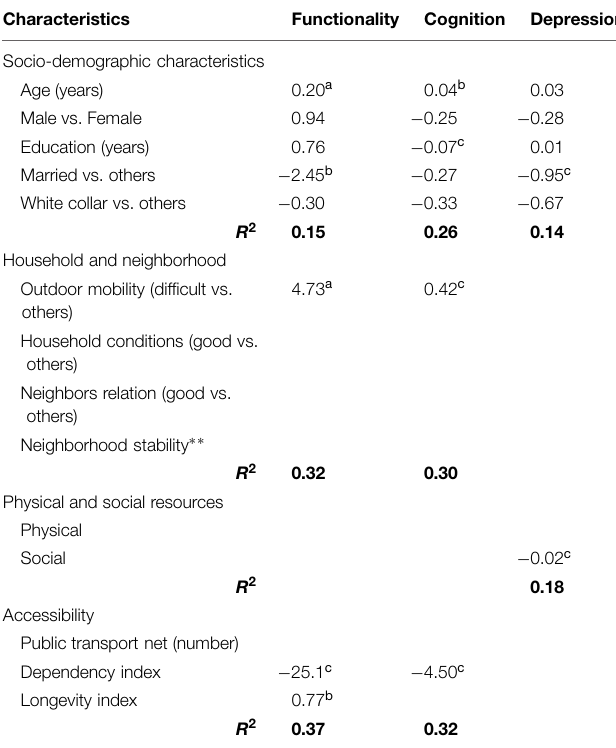
TABLE 3 | Multiple regression models ∗ for functionality, cognitive performance, and depression including micro and macro environmental